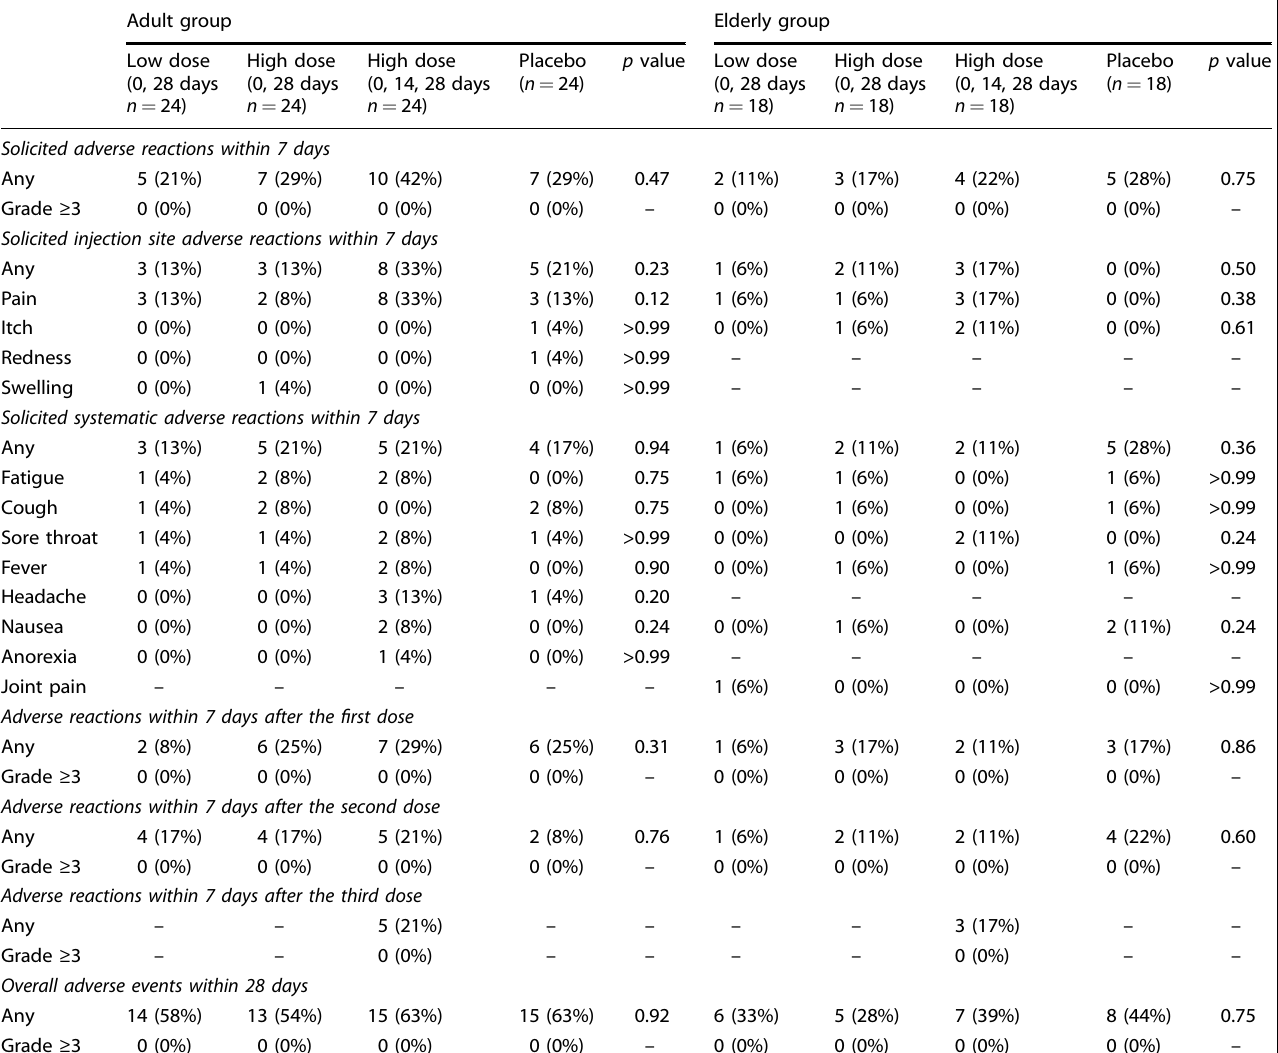
Table 2. Adverse reactions within 7 days and overall adverse events within 28 days after vaccination in phase 1